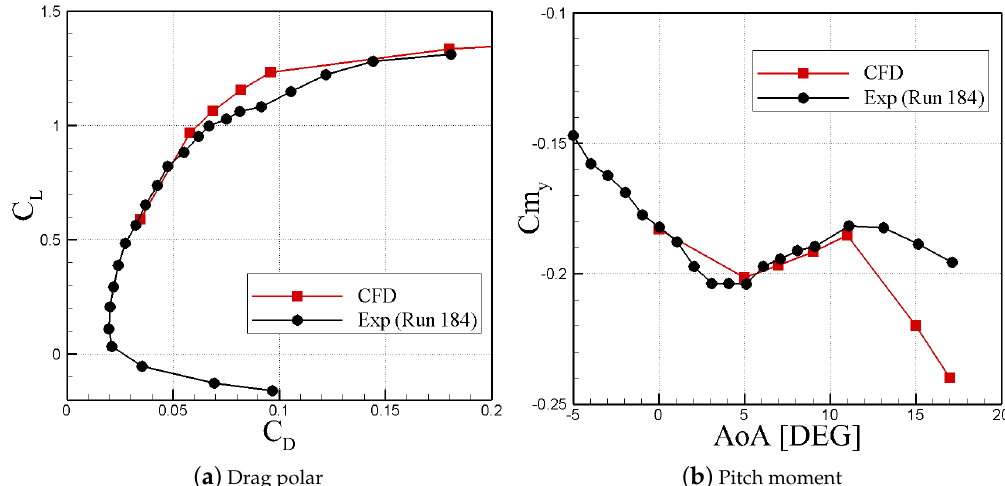
Figure 7. Validation of the integrated forces and moments of the no propeller case.